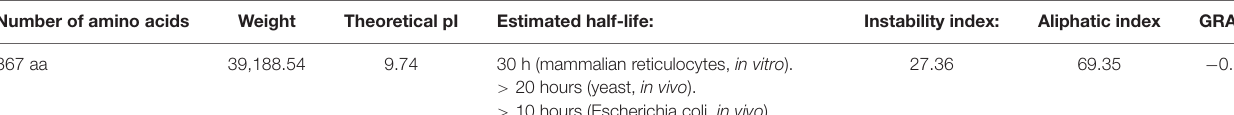
TABLE 3 | Physicochemical property of C543P predicted by the Expasy Protparam.